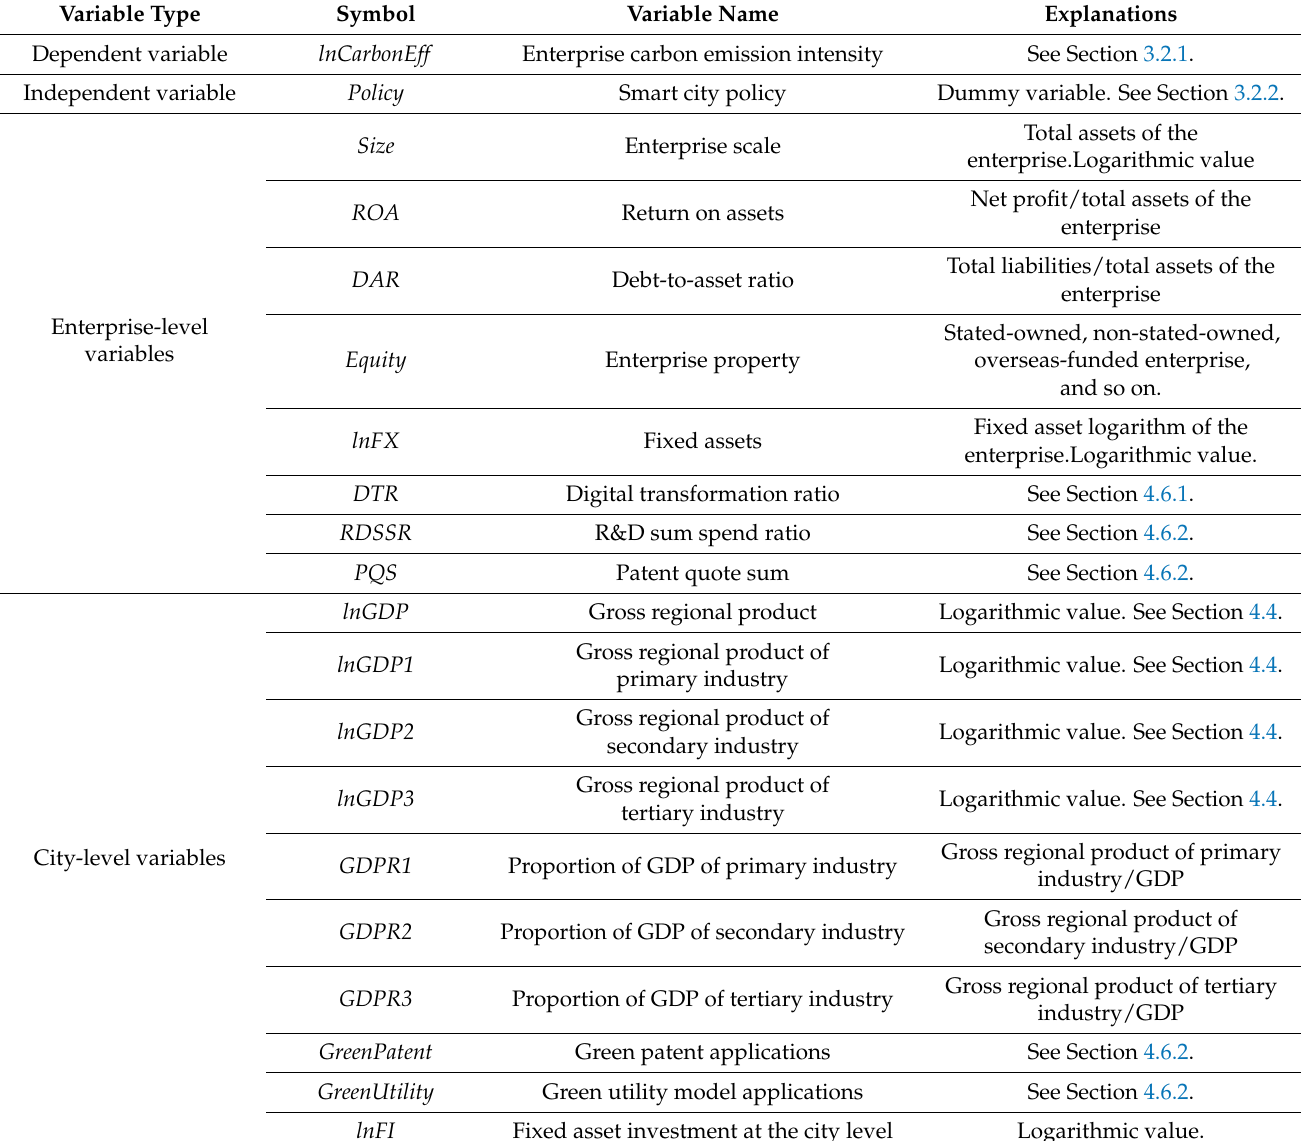
Table 1. Primary variables and